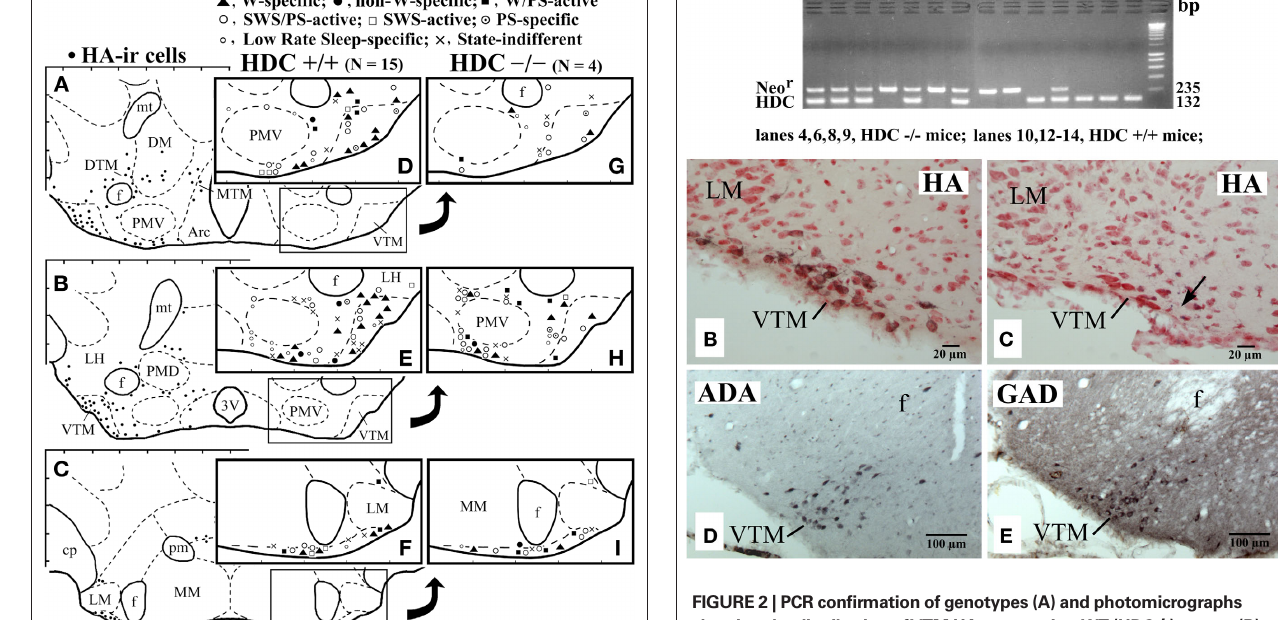
Figure 2 | PCr confirmation of genotypes (A) and photomicrographs showing the distribution of VTM HA neurons in a WT (HDC + / + ) mouse (B), of VTM neurons lacking histamine in a HDC-KO (HDC − / − ) mouse (C), and of VTM neurons immunoreactive for ADA (D) or for gAD67 (e) in a HDC-KO mouse. In (A) , note that all HDC + / + mice displayed a 132-bp band corresponding to the HDC gene fragment, whereas all HDC − / − mice showed a 235-bp band corresponding to the Neo r gene fragment. In (B,C) , the sections are counterstained with neutral red. The arrow in (C) indicates the recording site of a W-specific neuron. Note that in (B,C) , the sections are from the caudal region of the VTM corresponding to the caudal magnocellular nucleus consisting of large cells that form a compact group along the basal mammillary region ( Figure 1C ). Note also that in (D,e) , the sections are from the middle region of the VTM ( Figure 1B ) and are adjacent to each